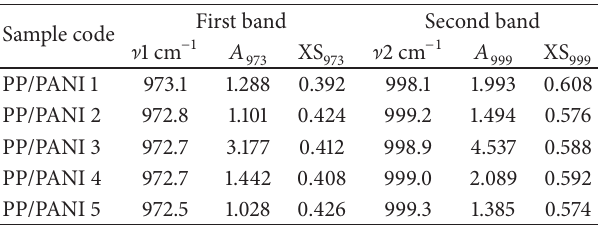
Table 3: Curve-fitting results for spectra of the region (950– 1020 cm −1 ).